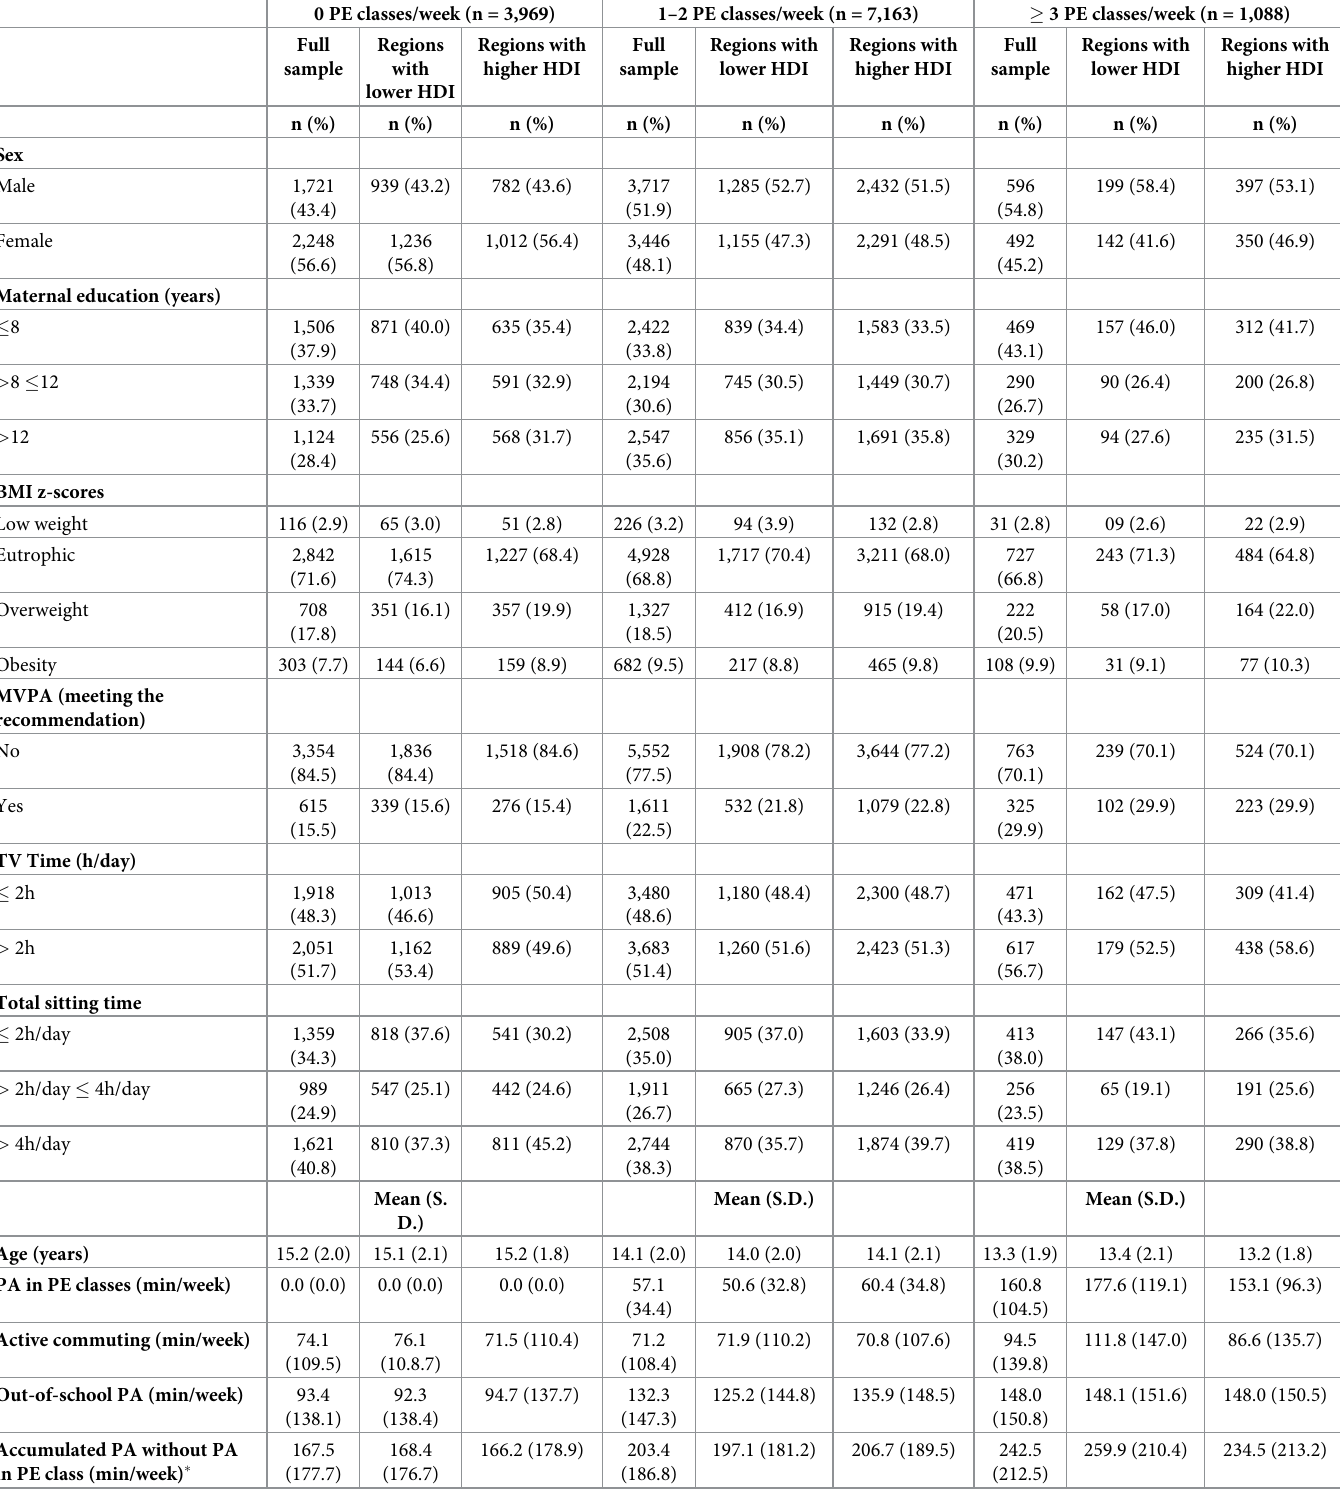
Table 1. Descriptive characteristics of the sample (n =